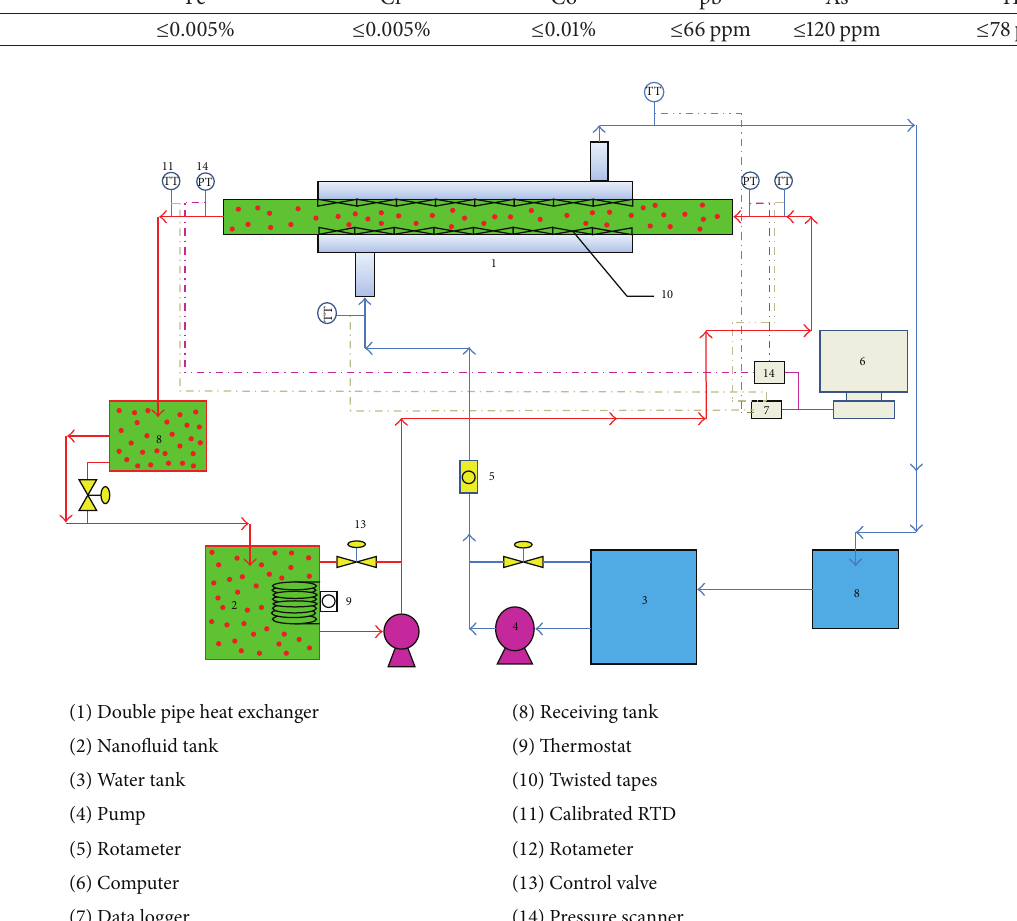
Figure 2: Schematic diagram of the experimental setup.